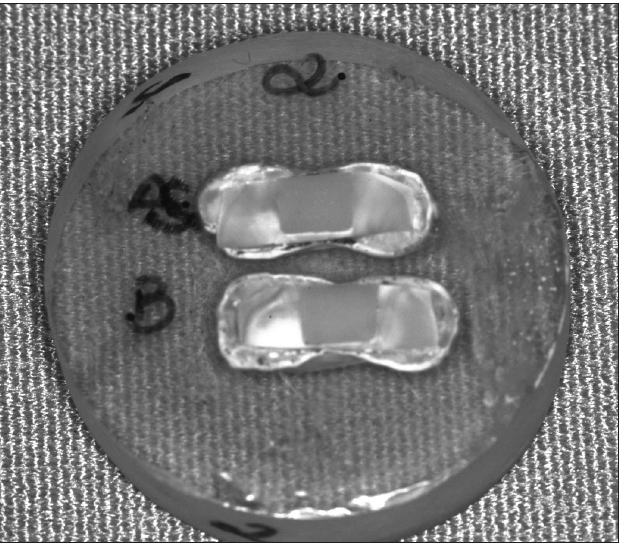
Figure 1. Specimen prepared for Knoop hardness